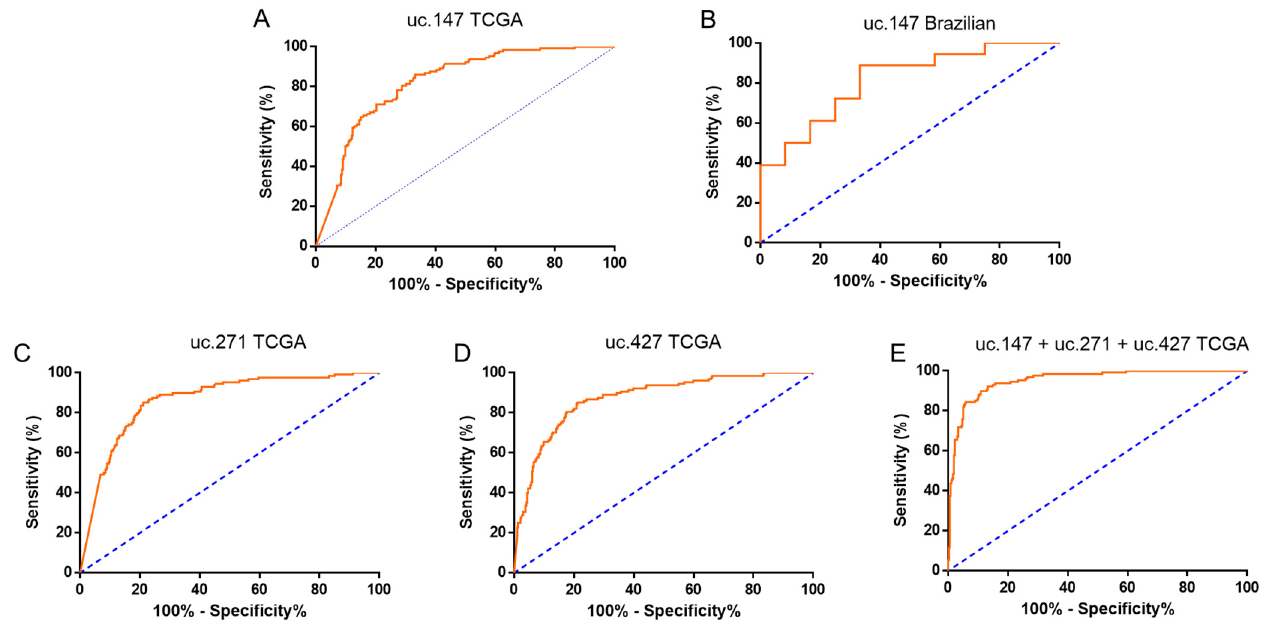
Figure 4. Individual and combined receiver operating characteristic (ROC) curves fromT-UCRs, indicating prognostic potential panels. BC prognostics accuracy calculated for uc.147 TCGA ( A ), uc.147 Brazilian cohort ( B ), uc.271 TCGA ( C ), and uc.427 TCGA ( D ). ( E ) BC prognostics accuracy calculated for uc.147 from Brazilian cohort. ROC curves calculated based on relative quantification (RQ) values.